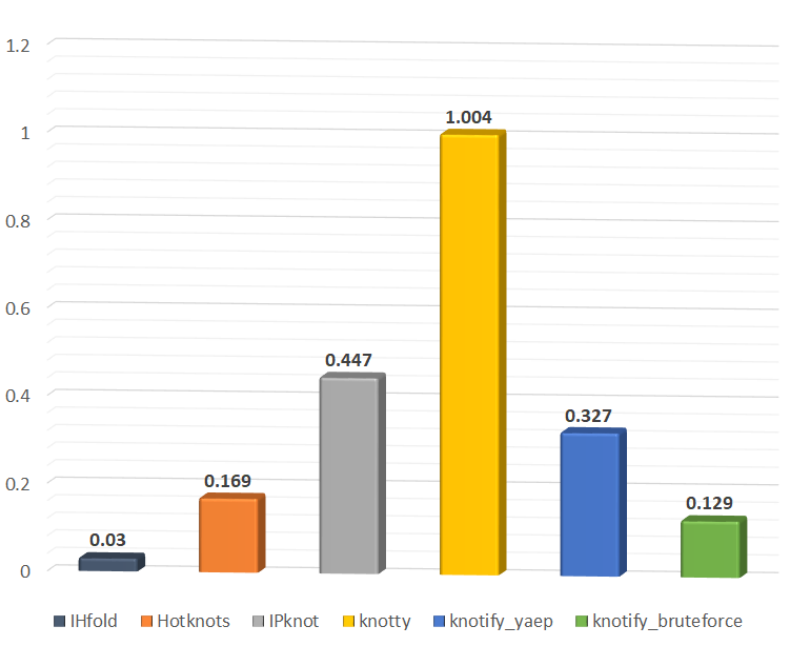
Figure 11. Average execution time (s) required per platform.